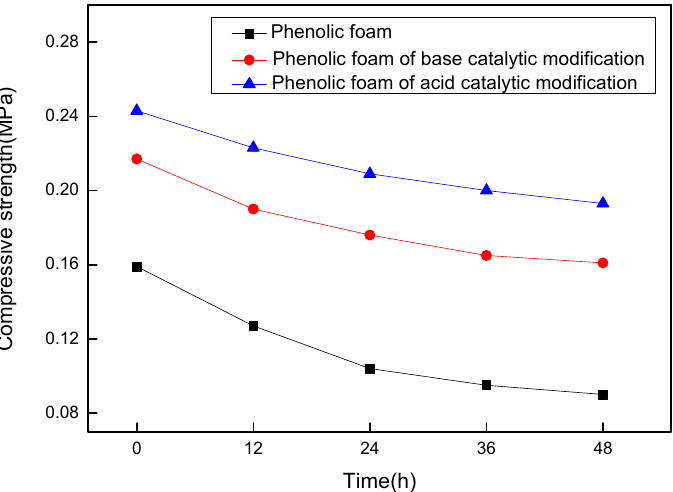
Figure 9. Compressive strength variation curve of phenolic foam and modified phenolic foam at certain aging time.